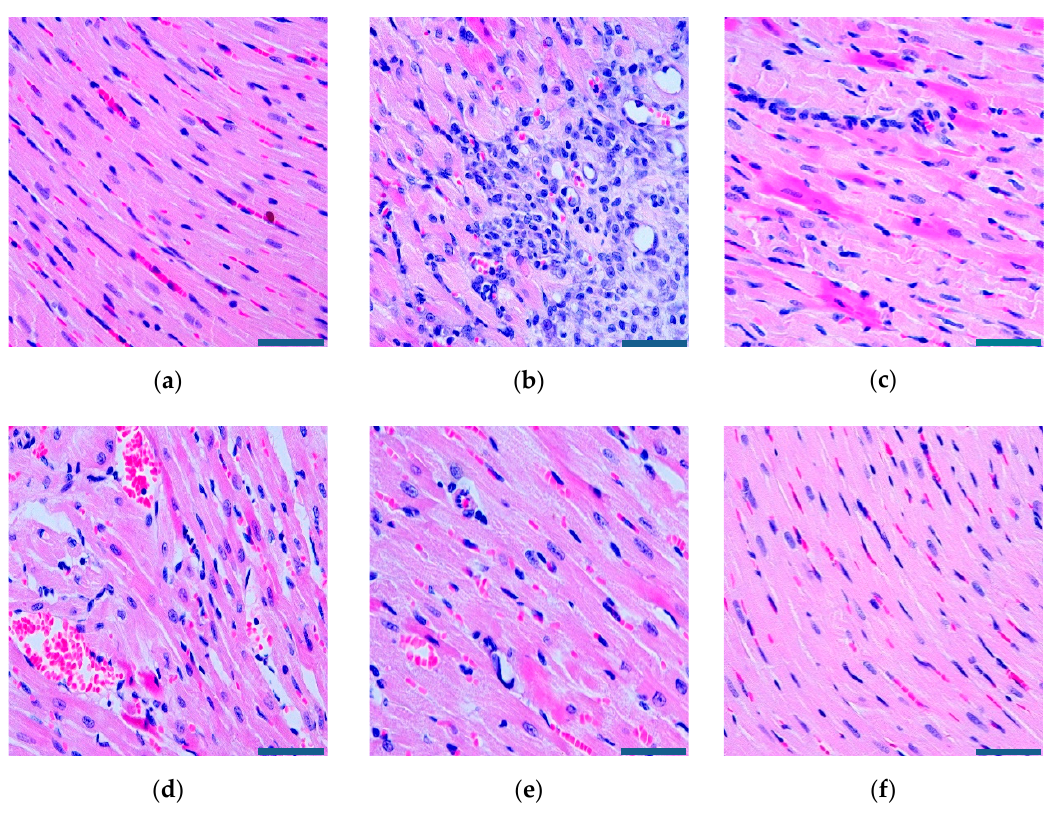
Figure 11. The myocardial histopathological representative changes of rats (×400, scale bar = 200 μ m) in ( a ) the sham group, ( b ) the model group, ( c ) the positive drug group, ( d ) the miR-133 group, ( e ) the PEG-PLA/miR-133 group, and ( f ) the RGD-PEG-PLA/miR-133 group.